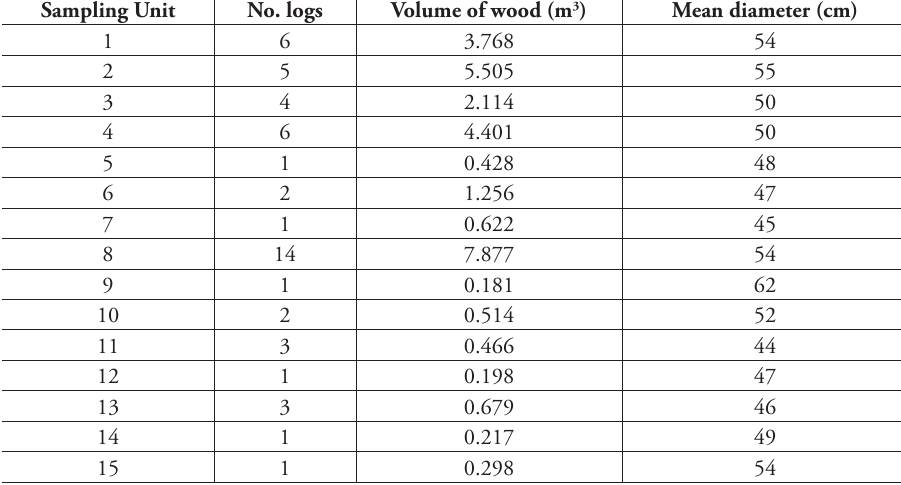
Table 2. Sampling units made by beech logs for the survey of R. alpina . Sampling Unit